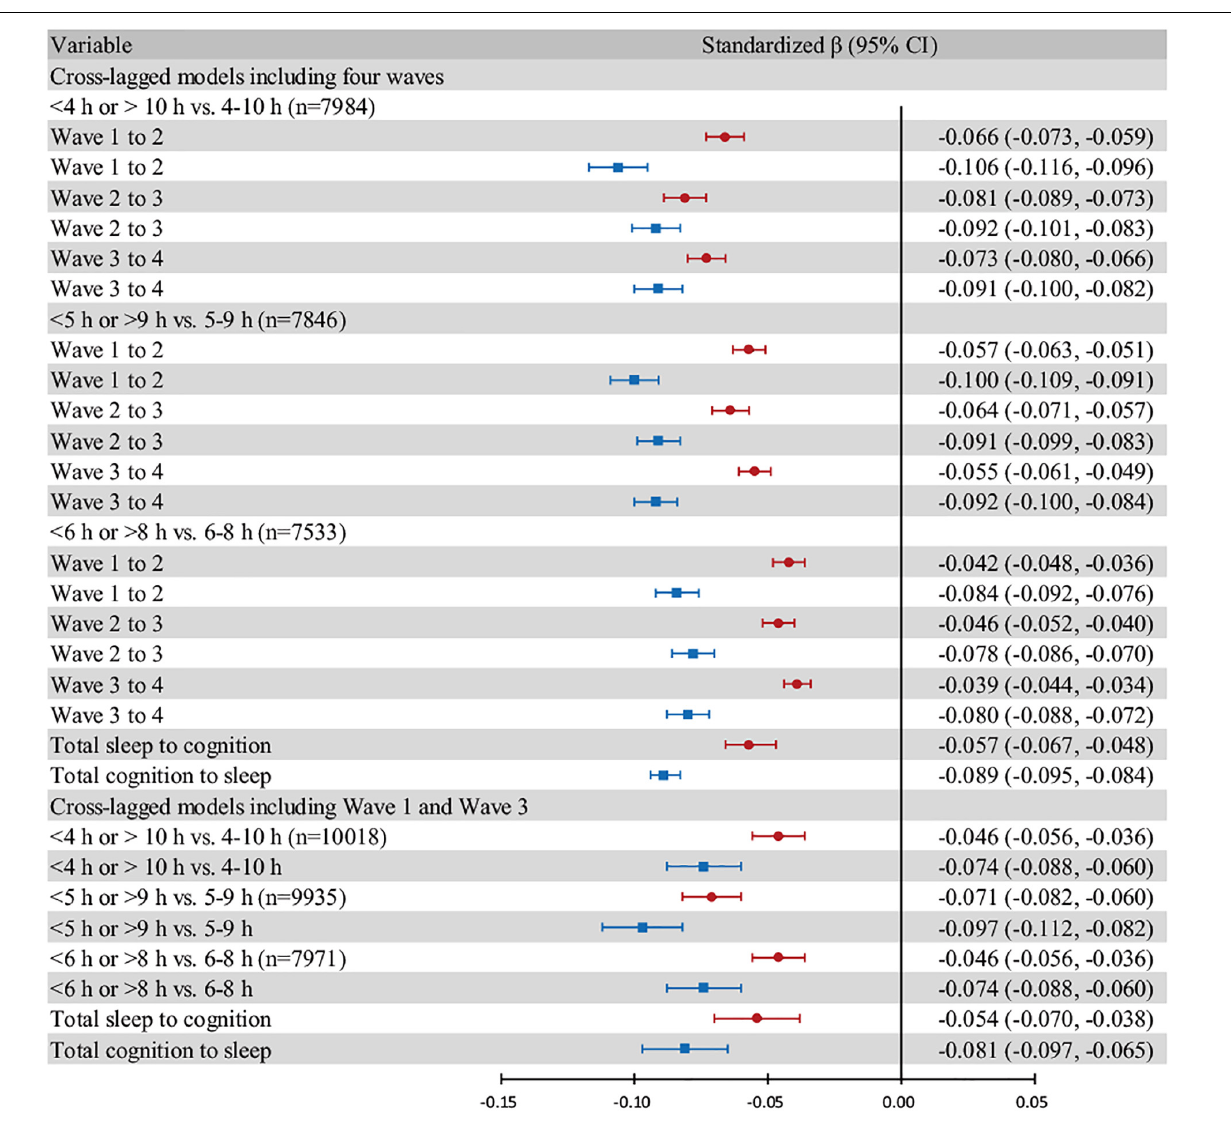
FIGURE 4 | Forest plot based on different cut-off points and models. Individuals who exhibited “excessive change” are excluded. All models are adjusted for age, sex, and living area. The red bars show the effect of sleep duration in the previous wave on global cognition in the next wave. The blue bars show the effect of global cognition in the previous wave on sleep duration in the next wave. The “total” group represent the pooled effect. Error bars show the standardized beta coefficient (points) and 95% CIs